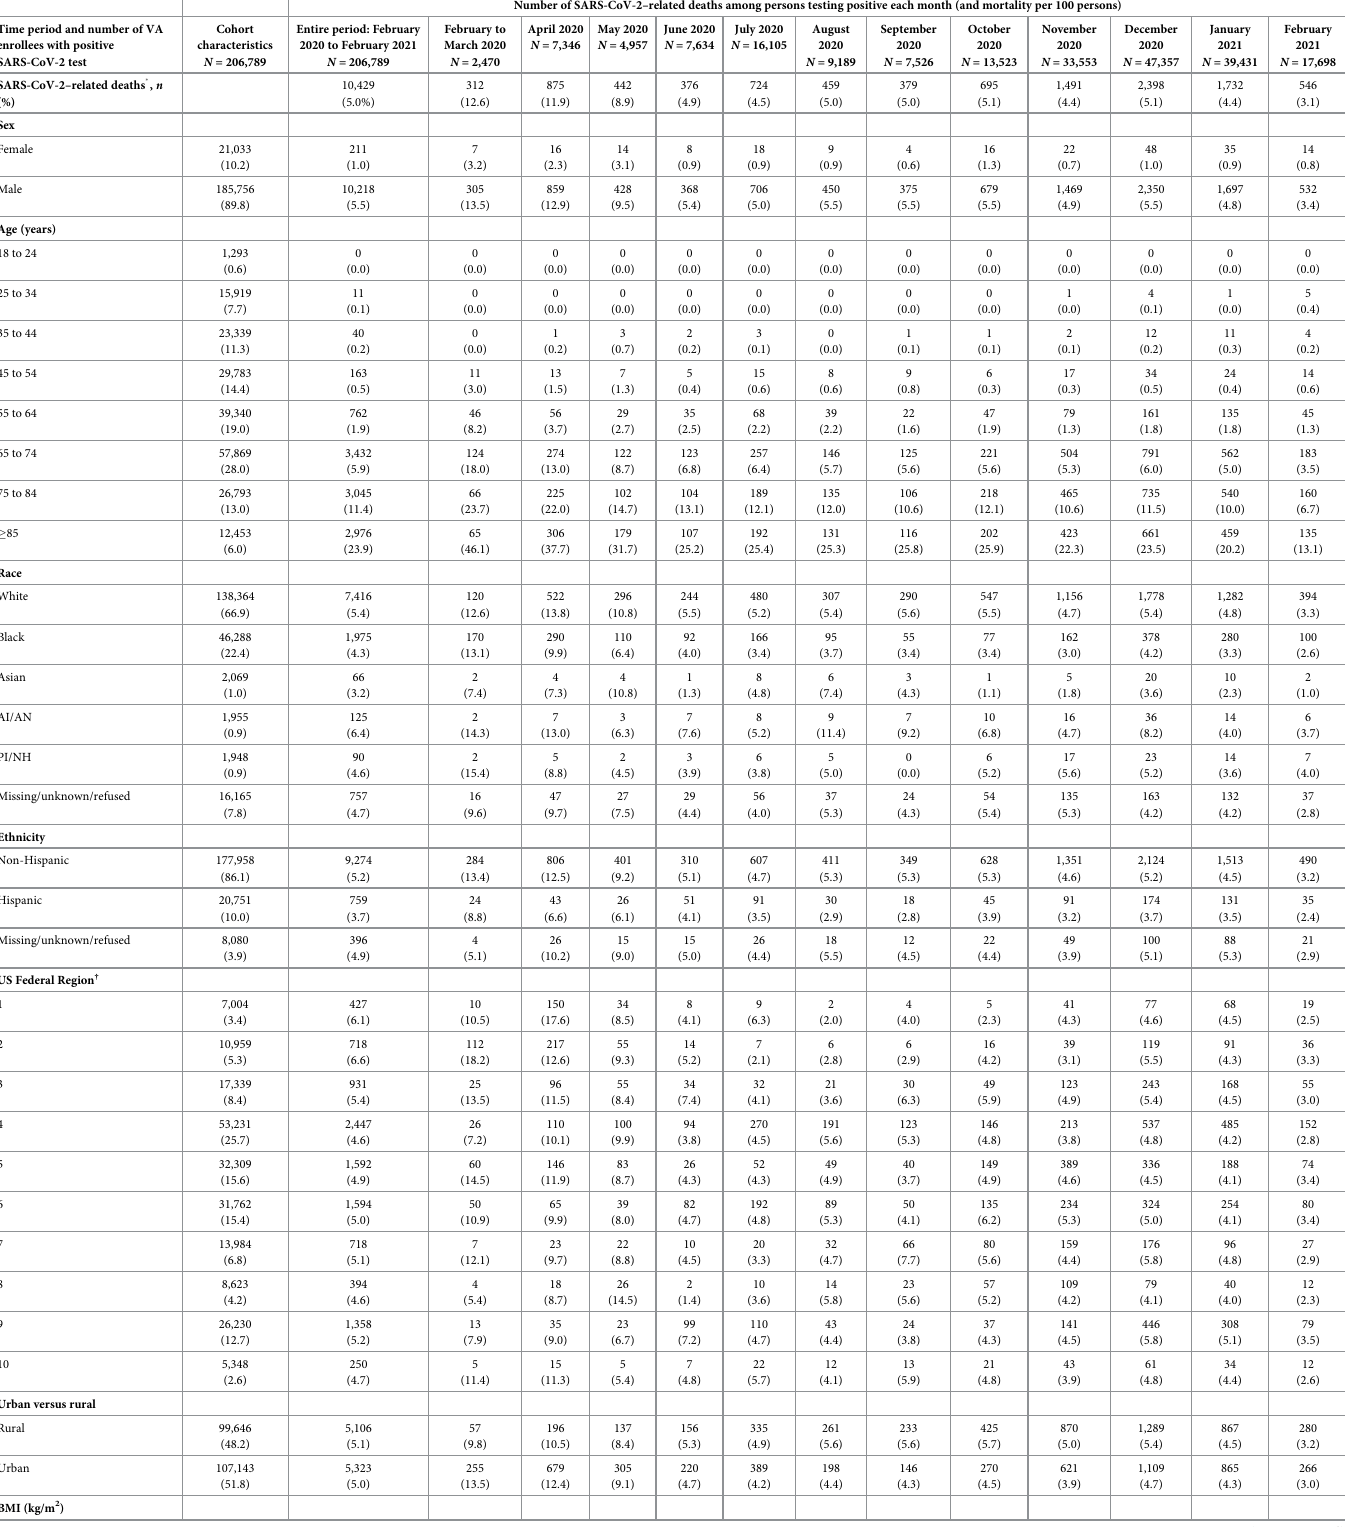
Table 5. SARS-CoV-2 case fatality presented for VA enrollees who tested positive for SARS-CoV-2 each monthly period from February 2020 to February 2021. NumberofSARS-CoV-2–relateddeathsamongpersonstestingpositiveeachmonth(andmortalityper100persons) TimeperiodandnumberofVA enrolleeswithpositive